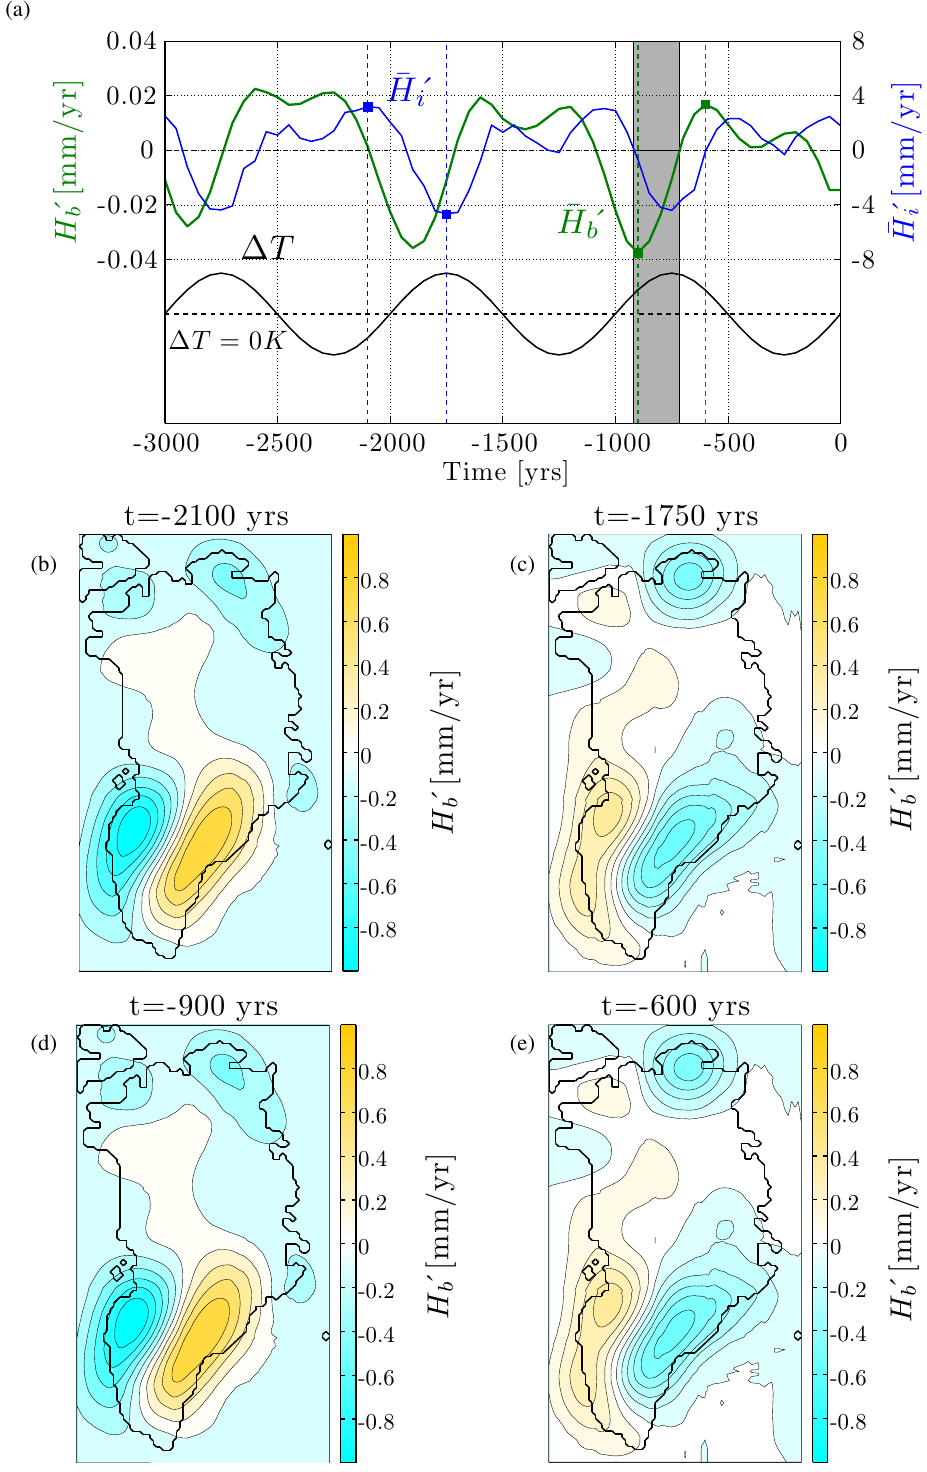
Fig. 1. (a) Time evolution of the spatial average ¯ H 0 (green line) and ¯ H 0 (blue line) for a forcing (black line) that schematically simulates temperature variations during the last 3000yr of the Holocene. The grey rectangle illustrates the 200yr delay between the start of ice thinning ( ¯ H 0 transition of positive to negative values) and onset of the bedrock response by uplift ( ¯ H 0 transition to negative values). (b–e) Spatial patterns of bedrock elevation changes for time slices where (b) ¯ H 0 reaches its maximum value, (c) ¯ H 0 is at its minimum, (d) ¯ H 0 is at its minimum, and (e) ¯ H 0 is at its maximum.